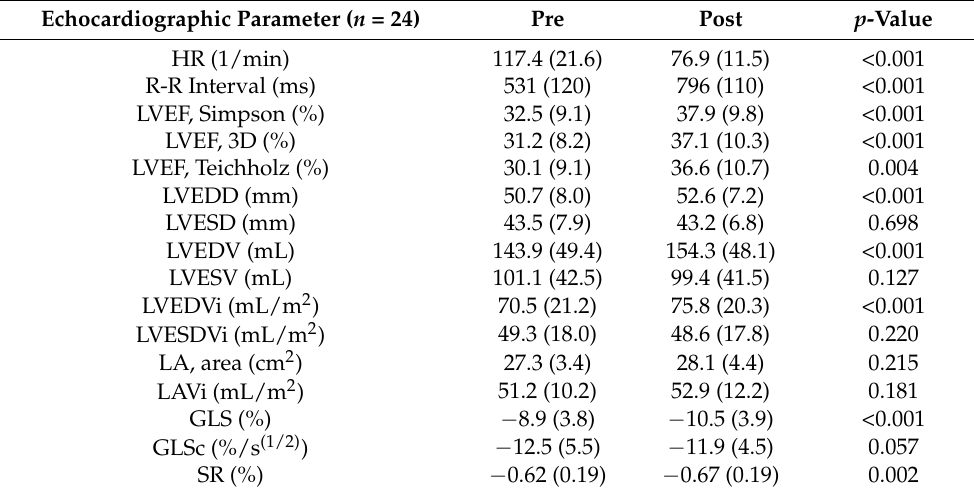
Table 2. Comparison of Echocardiographic Parameters Pre and Post Electrical